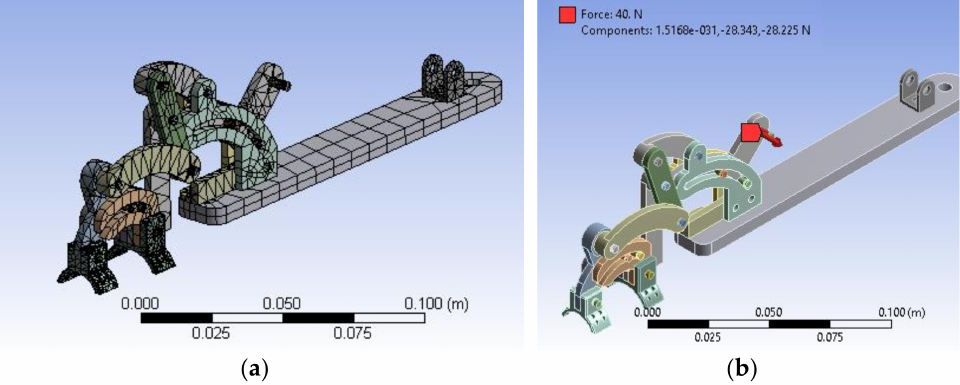
Figure 9. ( a ) CAD design in ANSYS exported from SolidWorks. ( b ) Maximum force by a linear actuator.